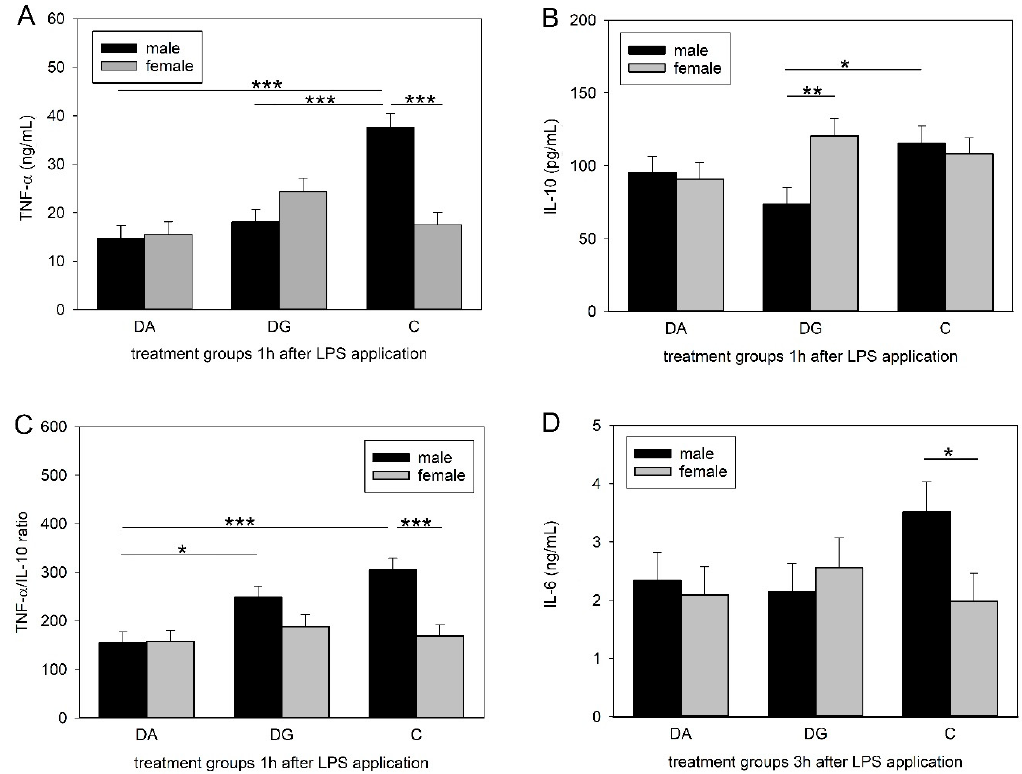
Figure 3. Plasma concentrations of TNF- α ( A ) and IL-10 ( B ) and the TNF- α / IL-10 ratio ( C ) 1 h after LPS application and plasma concentration of IL-6 ( D ) 3 h after LPS application in male and female piglets of the three treatment groups of DA (deprivation alone), DG (deprivation with a group of littermates) and C (control, no deprivation). Significant di ff erences are indicated by asterisks (* p < 0.05; ** p < 0.01; *** p < 0.001; n = 8 pigs per treatment group and sex).